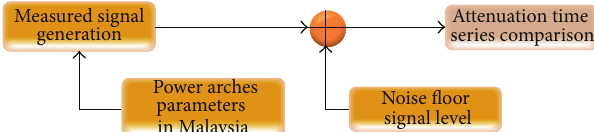
Figure 5: Block diagram measured with noise floor level.